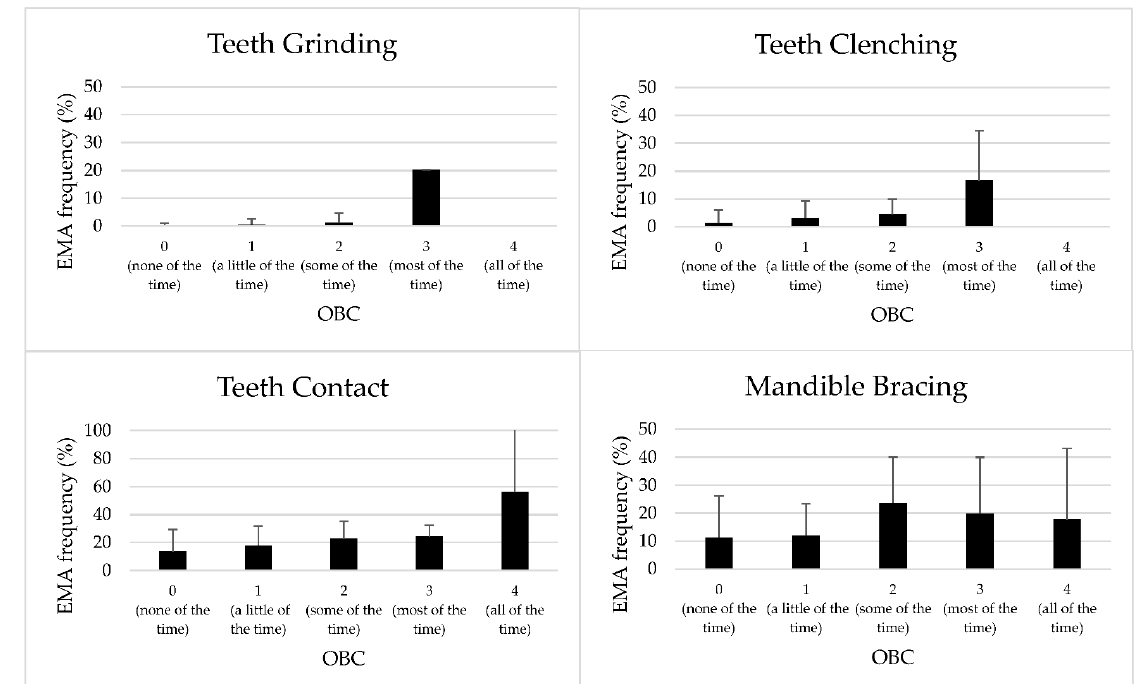
Figure 2. Mean frequency and standard deviation of each condition recorded with the smartphone- based application for Ecological Momentary Assessment (EMA) over a 7-day period, according to the different responses of the corresponding Oral Behaviour Checklist (OBC) questions.